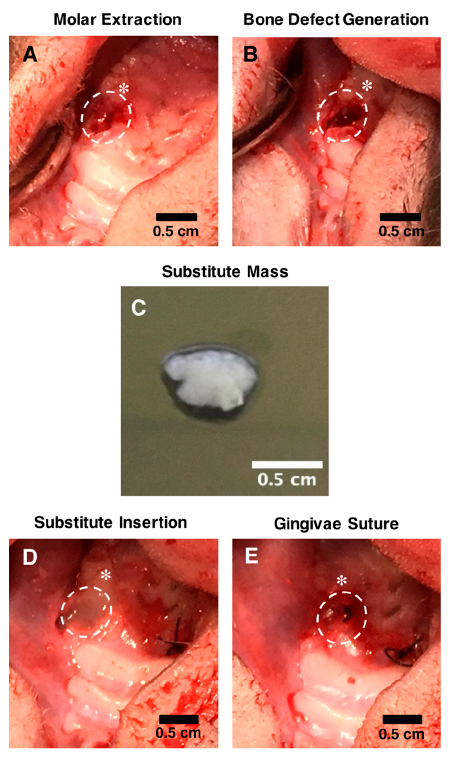
Figure 6. Surgical procedure to assess alveolar bone preservation within a nude RNU rat model. ( A ) Two front molars were extracted bilaterally from the superior maxilla of the rats, and ( B ) 4 mm 3 holes were subsequently generated using a drill to simulate bone loss following tooth extraction. ( C ) Before grafting, the engineered substitutes were detached from the peripheral anchoring device used during culture and compacted into a tissue mass. ( D ) Bone defects were filled with the substitutes (random allocation) when applicable, and ( E ) gingivae were sutured to maintain the substitutes in the socket. Dotted white circles show the implantation site. The white stars indicate the remaining molar. Scale bars: 0.5